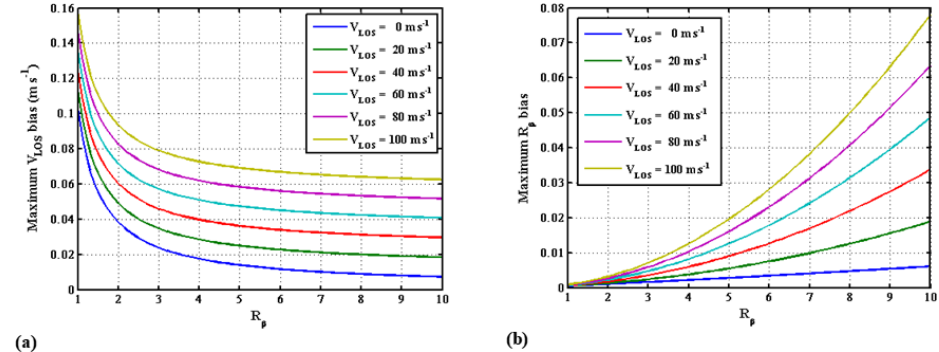
Figure 12. Maximum measurement bias for a 10 − 3 relative calibration error in the sensitivity a i of one QMZ channel, as a function of the scattering ratio. (a) LOS velocity error. (b) Scattering ratio relative error for different LOS velocities (VLOS).